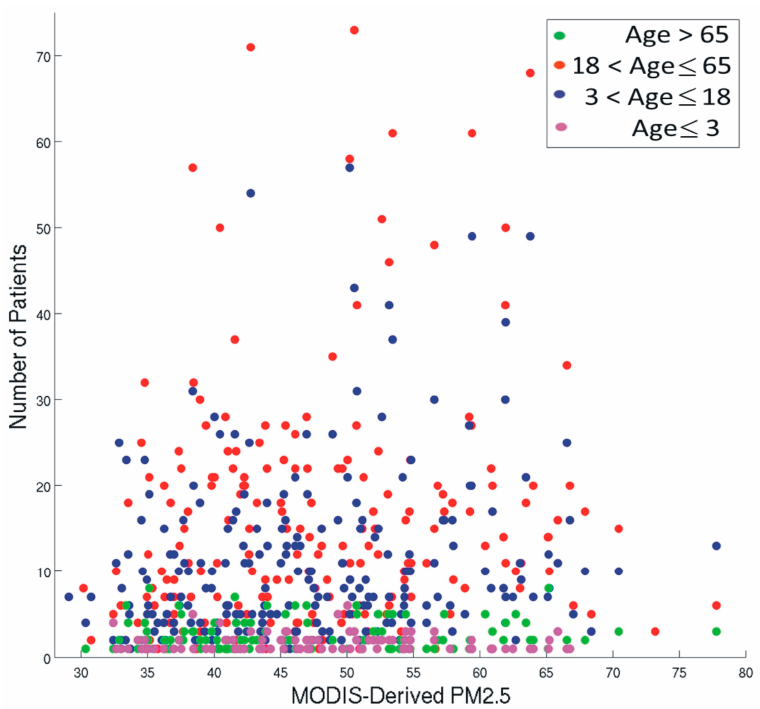
Figure 5. Scatter plot of satellite-derived PM 2.5 ( x -axis) against daily numbers of allergic rhinitis patients among four age groups for the year of 2008.